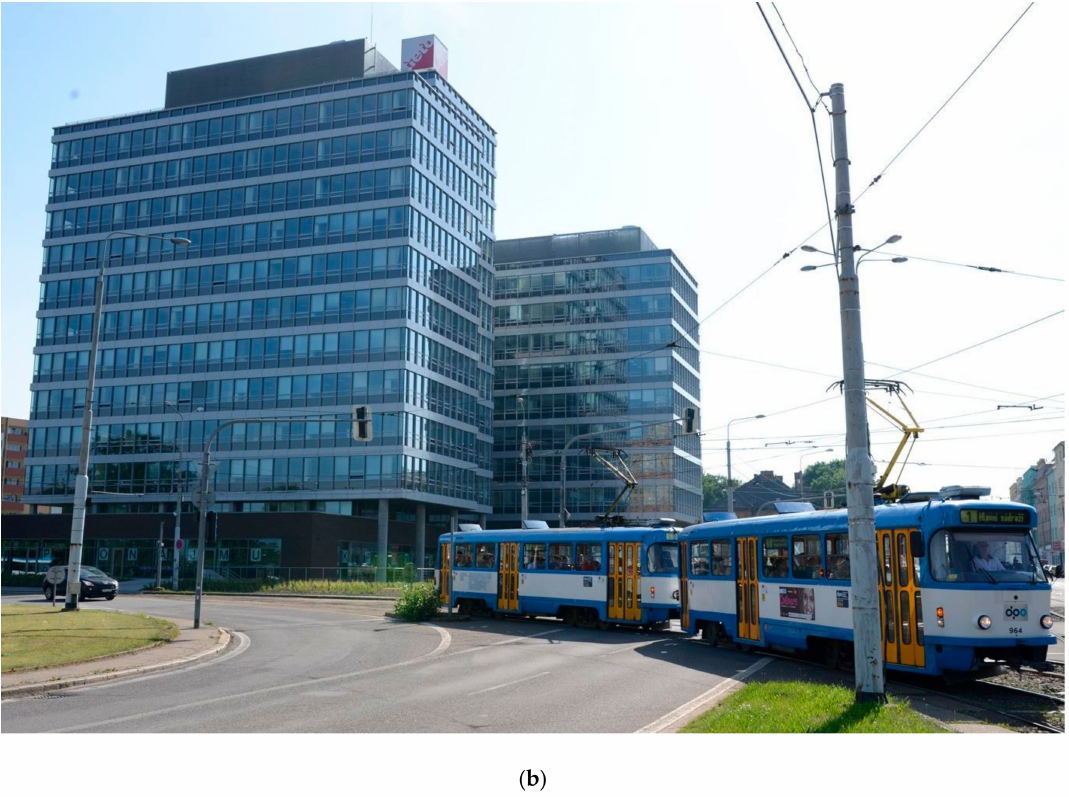
Figure 7. ( a ) Hub C: building on Hornopoln í street, location C1, ( b ) Hub D: selected buildings hosting ICT firms, location D1 (photo source: Tieto Czech, s.r.o.).